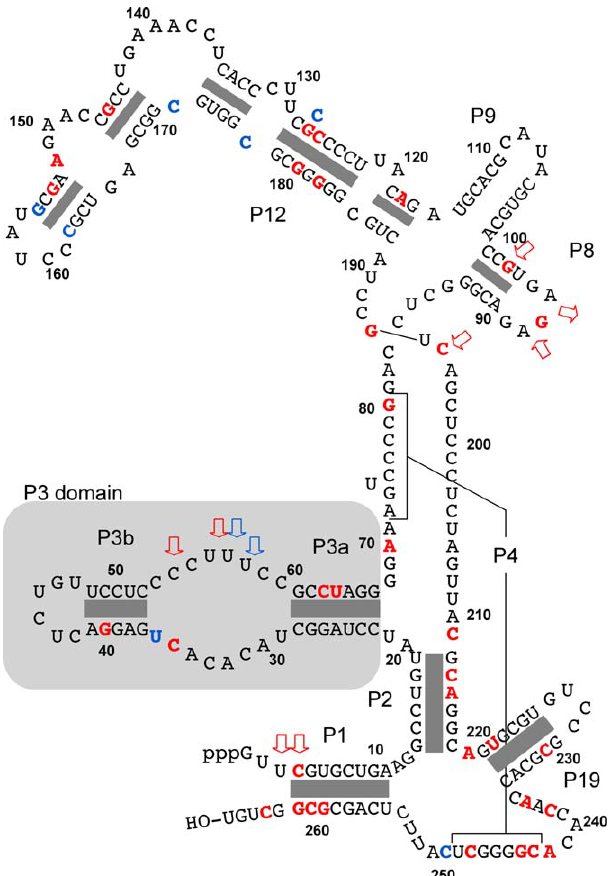
The RNA molecule of the human RNase MRP complex is shown according to the model of Welting et al. [29]. Nucleotides affected by mutations (single nucleotide changes) are in red; polymorphisms and rare variants are in blue. Insertion/duplication/deletions are indicated as red (mutations) or blue (putative polymorphisms) arrows. Regions of base-pairing are indicated as gray boxes. The P3 domain (nucleotides 22–66) is shaded. DOI: